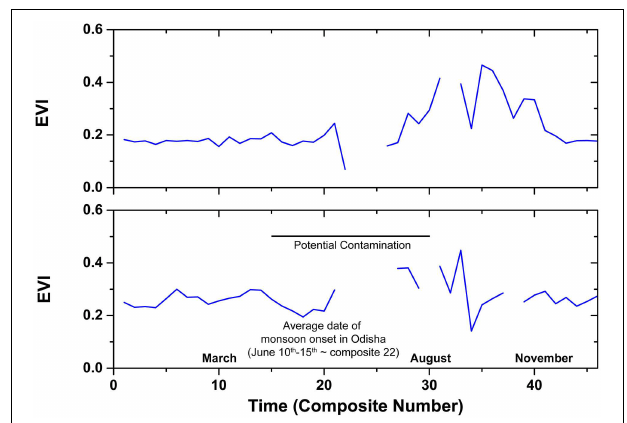
FIGURE 1 | Missing values in the EVI time-series generated using the MODIS MOD09A1 product over two agricultural locations in Odisha, Eastern India in 2008. Missing values were detected using the MODIS quality assurance (QA) product; gaps in the time-series are where high-quality retrievals were not available to compute the